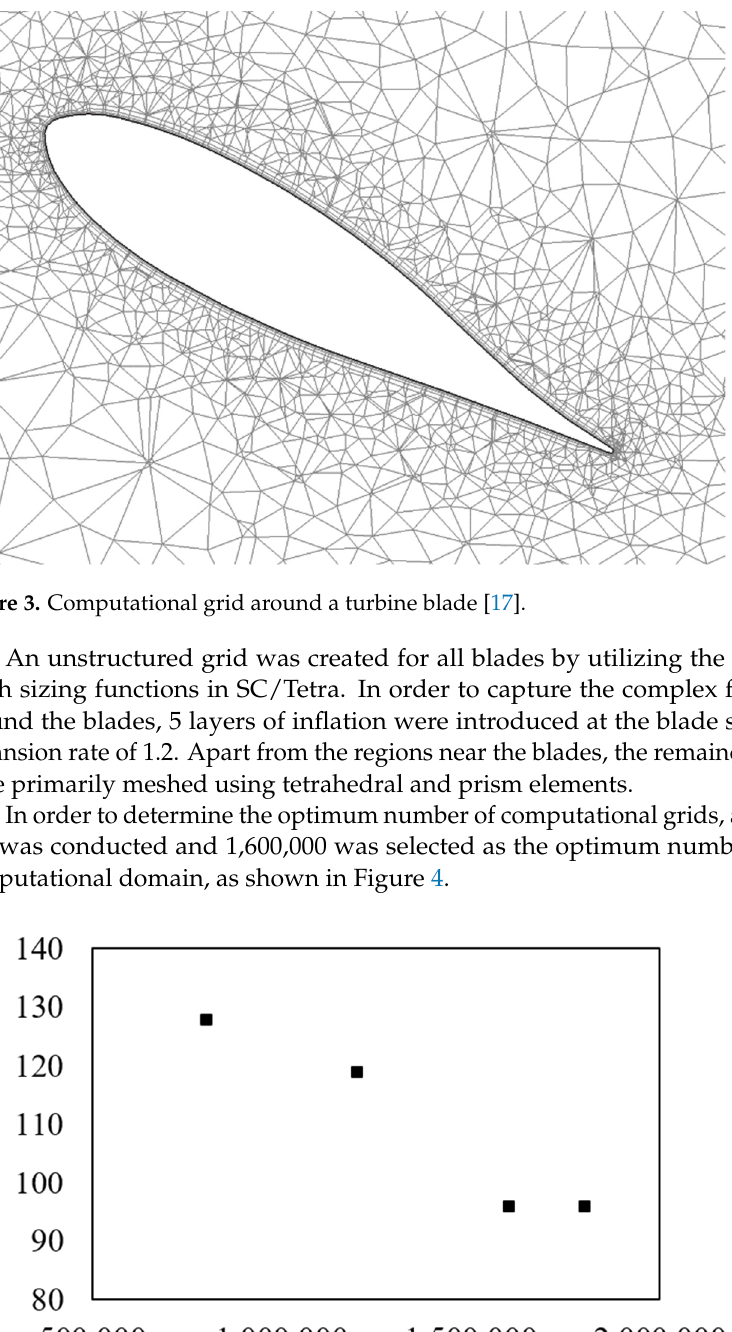
Figure 4. Grid independency test result [17].